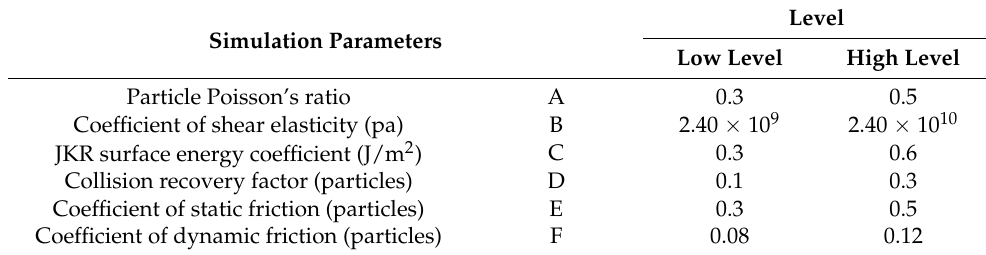
Table 1. Parameter calibration test of discrete element method calibration